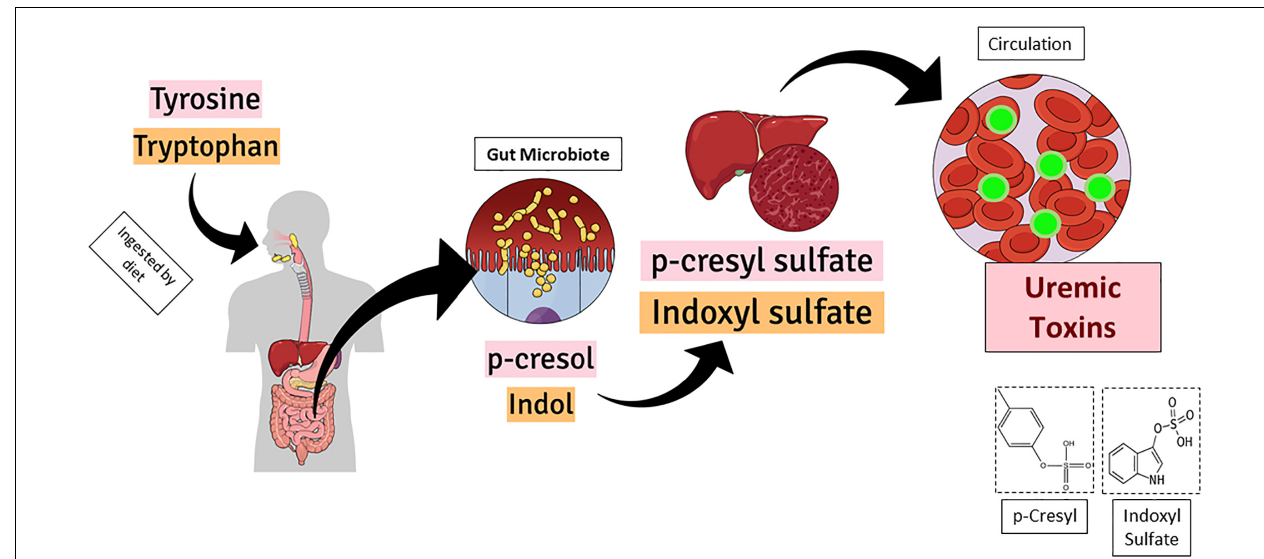
FIGURE 1 | Graphical representation of p -cresyl (PCS) and indoxyl sulfate (IS) formation inside the body. Both uremic toxins, p -cresyl sulfate and indoxyl sulfate are originate from the intestinal microbial metabolism of dietary amino acids. While the IS is delivered from the tryptophan, the PCS is delivered from tyrosine. After the chemical modifications occurred in the liver, both active metabolites reach the circulation and impact target